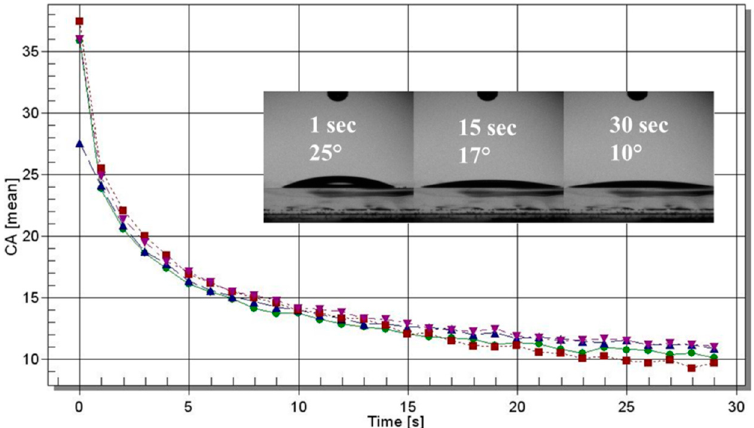
Figure 6. Contact angle of water on the surface of γ -PGA as a function of time. Four sets of data were plotted (the four curves with different colours refer to four drop tests). Pictures of the drop after 1, 15, and 30 s are shown in the insert.